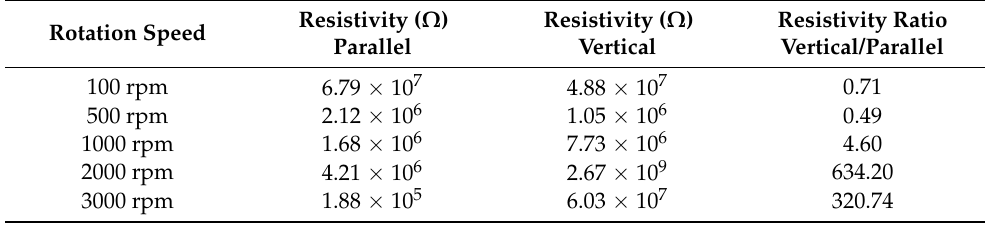
Figure 11. Tuac Plot and estimated energy band gaps of CuCrO 2 thin films prepared at different rotating speeds from 100 to 3000 rpm and annealed at 600 ◦ C. Table 3. Detailed electrical resistance values of CuCrO 2 thin films prepared at different rotating speeds from 100 to 3000 rpm and annealed at 600 ◦